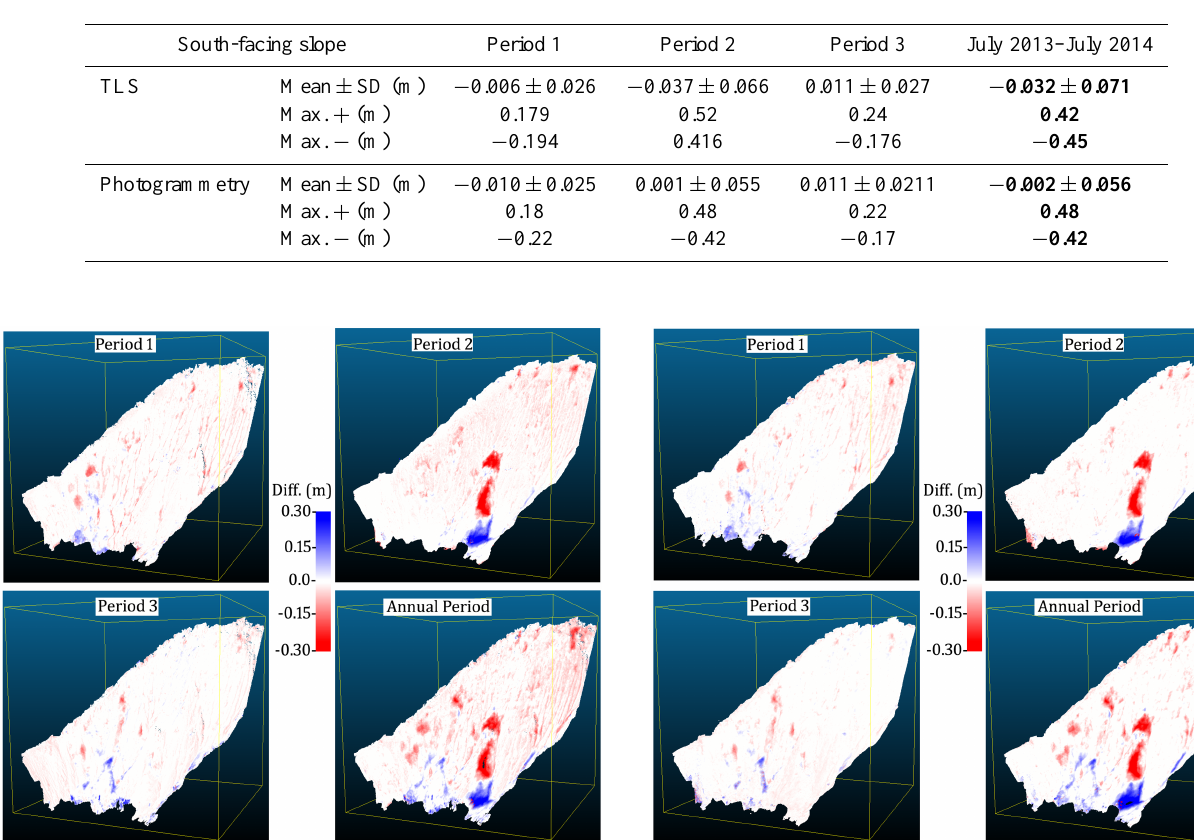
Table 3. Mean differences, standard deviation and maximum differences (Max. + , deposition; Max. − , erosion) of point clouds obtained for different survey periods with TLS and photogrammetry on south-facing slopes. Bold numbers indicate annual values.